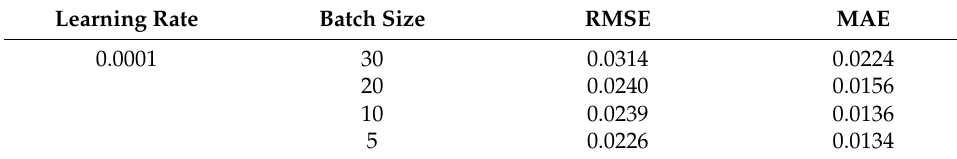
Table 3. Results of validation set prediction with different batch